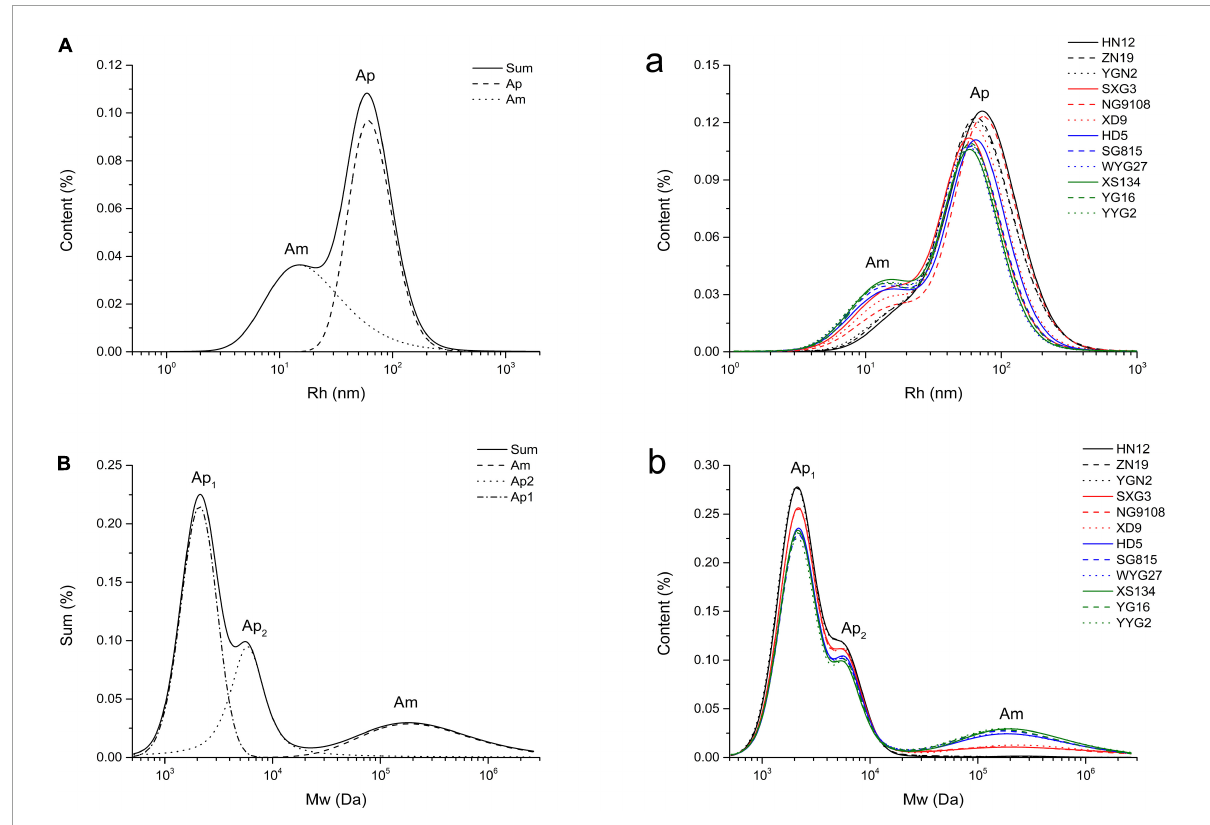
FIGURE1 Molecular size distributions of whole branched starches (A/a , Rh ) and debranched starches (B/b , Mw ) extracted from japonica